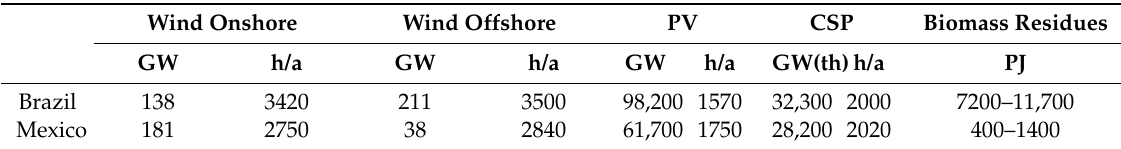
Table 3. Summary of renewable energy potentials.